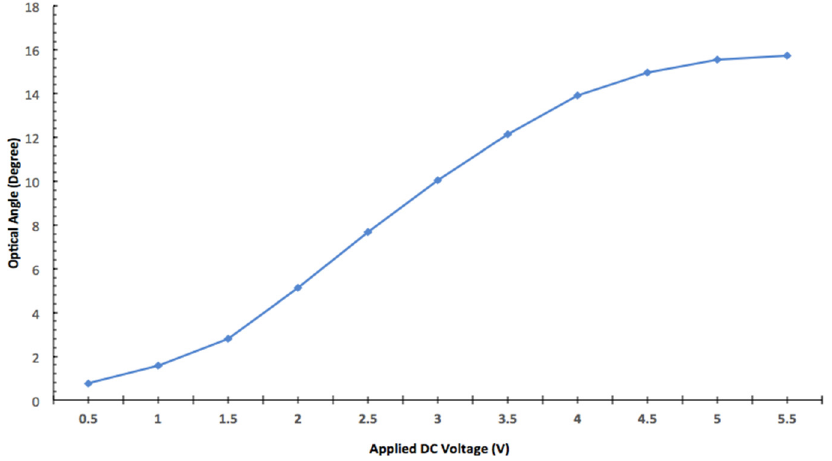
Figure 11. Quasi-static angular response of the MEMS mirror. Measurement errors: 0.1°.